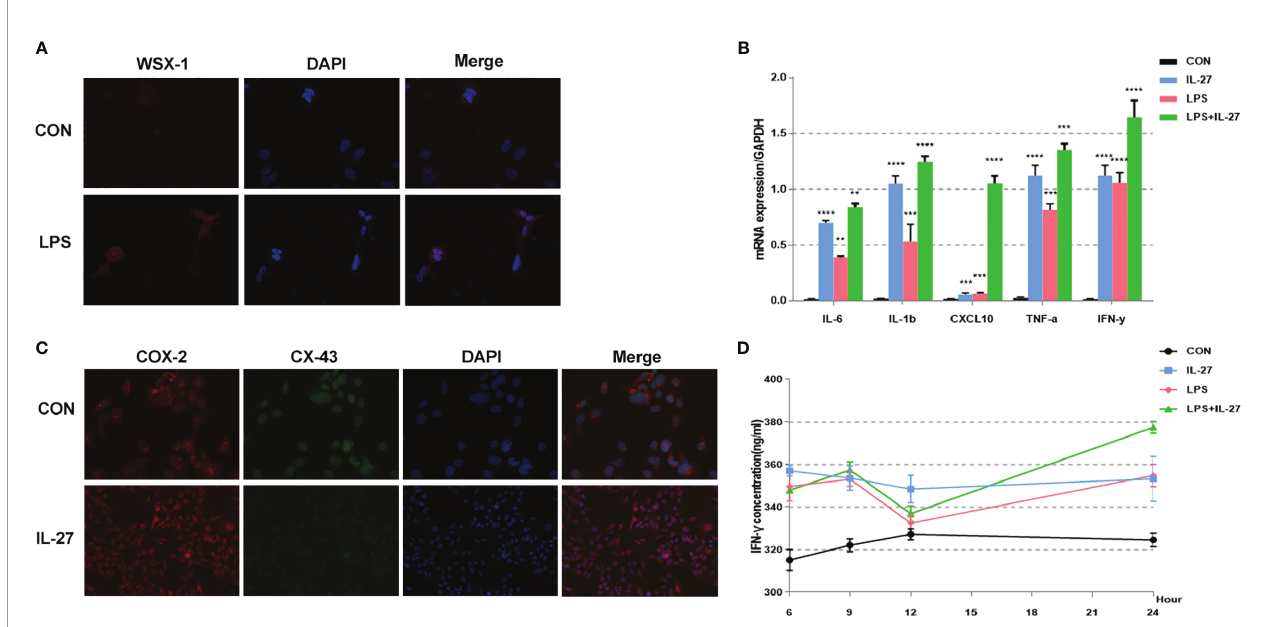
FIGURE 5 | Expression and localization of WSX-1 and iIn fl ammatory effects induced by IL-27 in HMSMC cells. (A) Immuno fl uorescence analysis of WSX-1 protein expression and localization in HMSMC cells treated for 6 h without (PBS) or with LPS (1 µg/ml). (B) Relative expression of a range of key cytokines, including TNF- a , IL1 b , IL6, IFN- g , and CXCL10, in WISH cells treated for 6 h without (CON) or with LPS (1 µg/ml) or IL-27 (50 ng/ml) or both factors, as measured by qRT-PCR. (C) double labeling and immuno fl uorescence analysis of CX-43 and COX-2 protein expression and localization in cells treated with or without IL27 (50 ng/ml) treatment